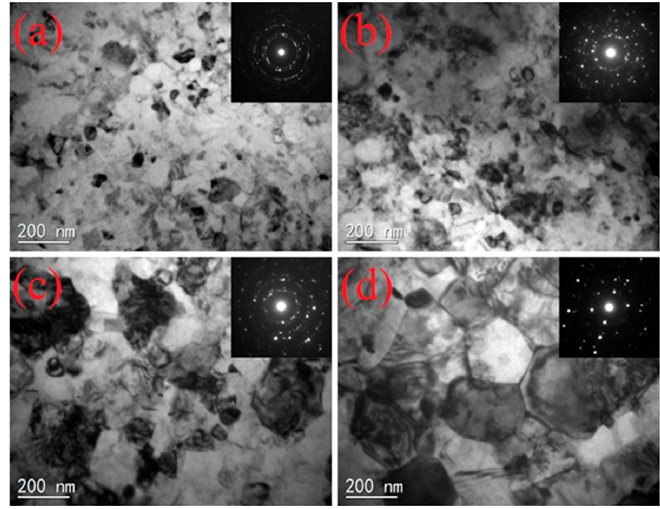
Figure 3. TEM images and corresponding SAED patterns of 120 min SMAT sample annealed for 5 h at different temperatures: ( a ) 550 °C; ( b ) 600 °C; ( c ) 650 °C; and ( d ) 700 °C.